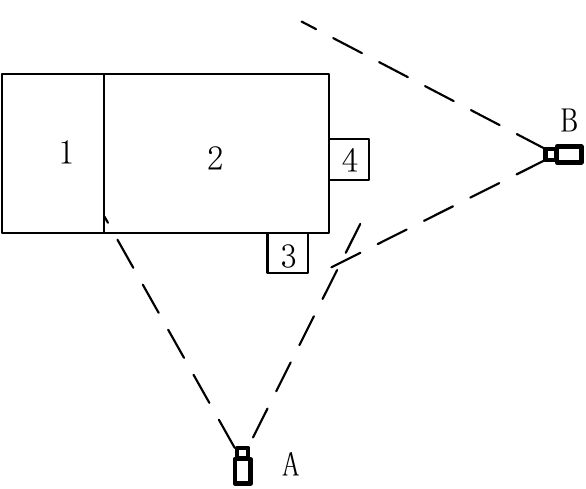
Figure 1. Video collection setup. 1 . Rest area; 2 . Activity area; 3 . Feeding-basin; 4 . Drinking-basin. A . Front-view camera; B . Side-view camera.